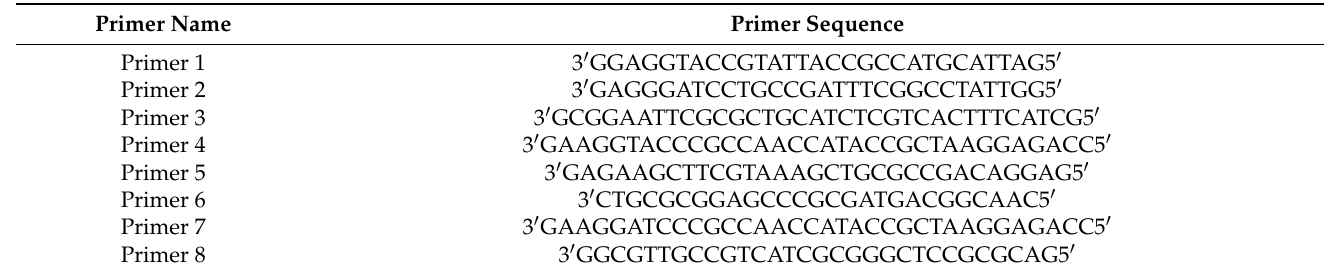
Table 2. Primer list for construction of ∆ gM BoHV-1 and ∆ gM Rev BoHV-1 recombinant